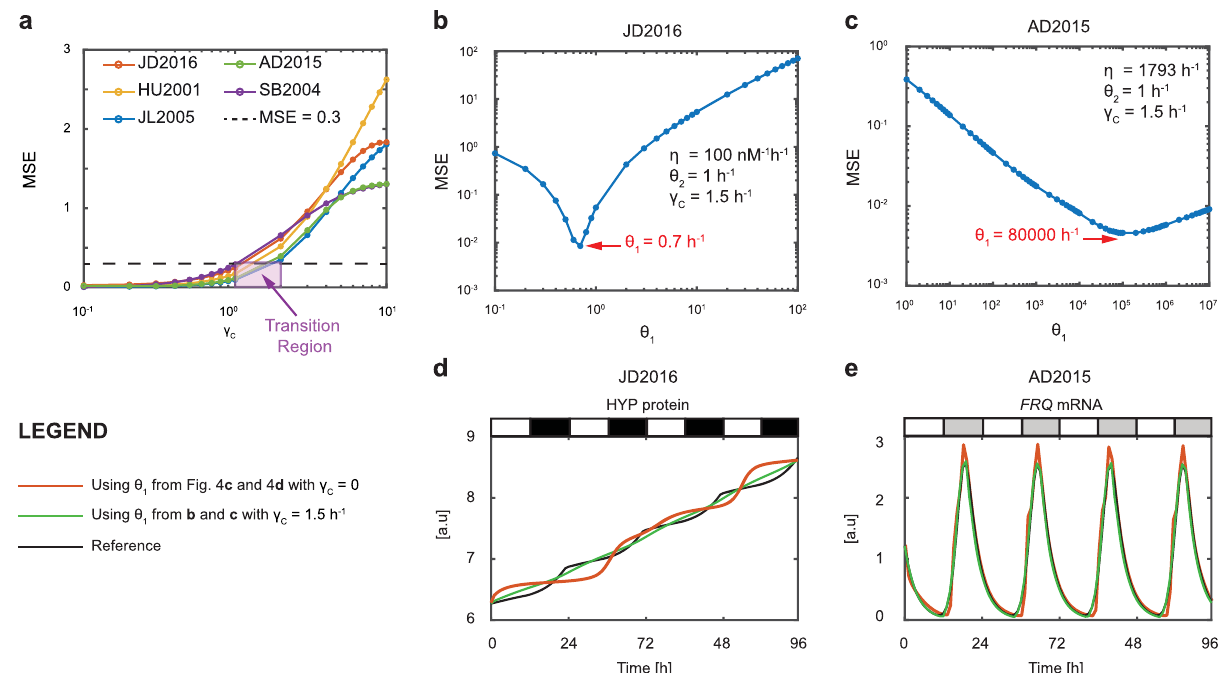
Fig. 4 Effect of varying AIF controller parameters when controller degradation is not zero. a Effect of varying γ C on MSE. b , d Plant clock, JD2016. c , e Fungal clock, AD2015. b , c Effect of varying θ 1 on the MSE. d , e Time series pro fi les obtained using the AIF controller with different values of θ 1